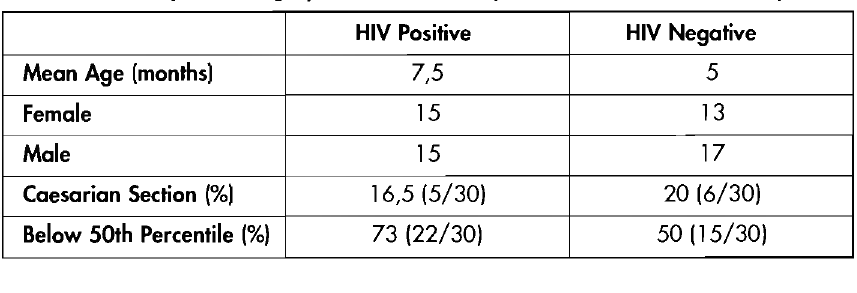
Table 2: Classification of Subjects According to Their NDS